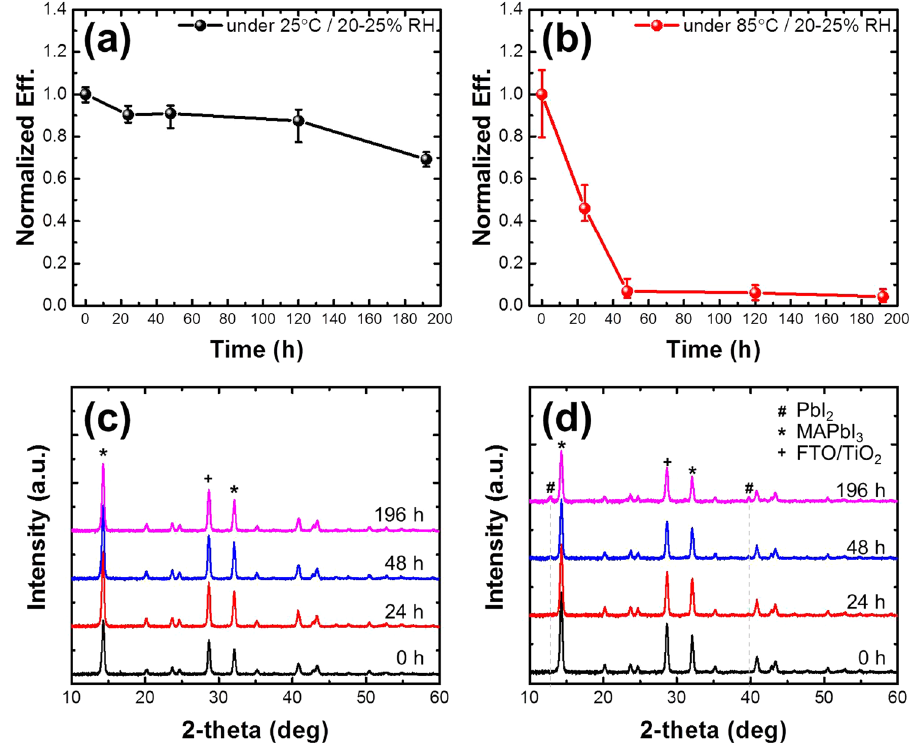
Figure 1. Long-term stability of MAPbI 3 PSCs and perovskite films: power conversion efficiency at ( a ) 25 °C and ( b ) 85 °C with time and X-ray diffraction pattern of FTO/TiO 2 /MAPbI 3 /spiro-OMeTAD structure at ( c ) 25 °C and ( d ) 85 °C with